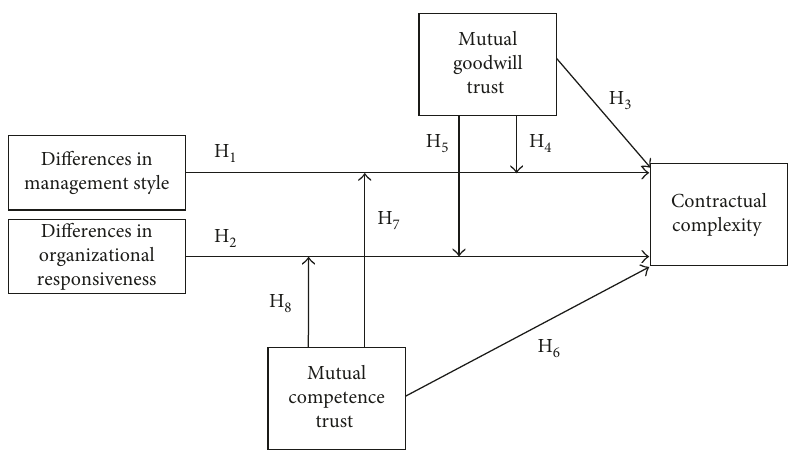
Figure 1: Conceptual model for the relationships between OCD, MT, and